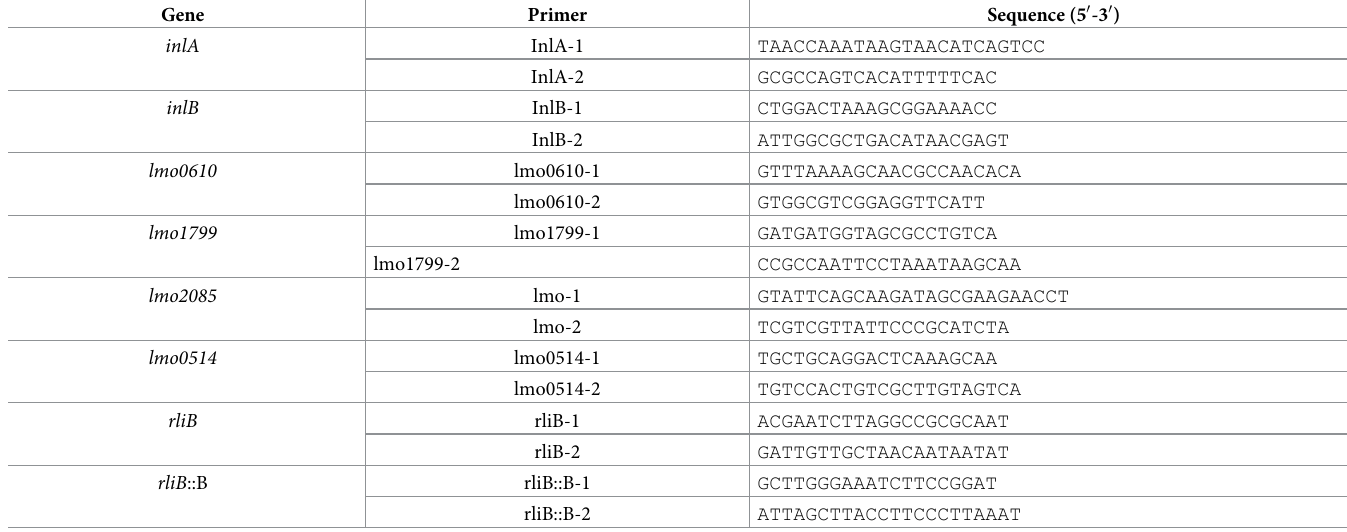
Table 1. Oligonucleotide primers sets used in this study.